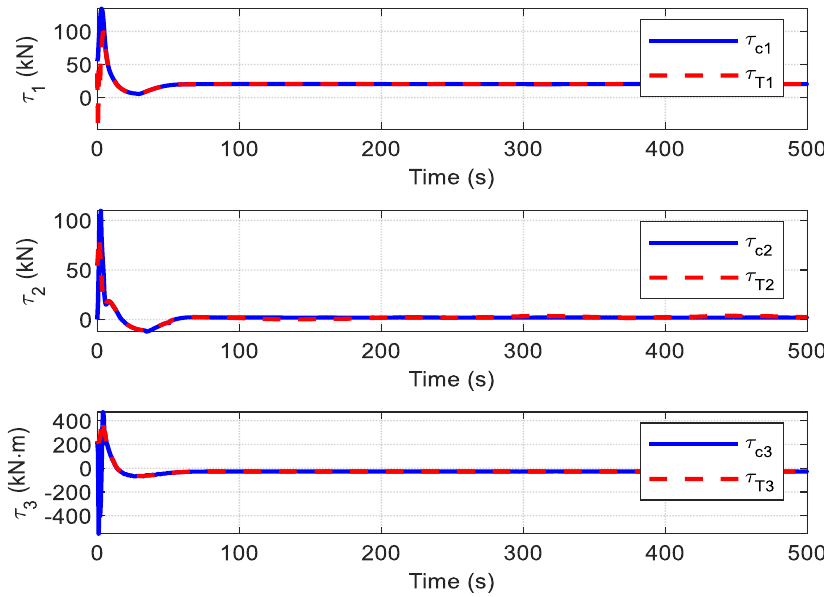
Figure 20. Control inputs τ c and thruster forces τ T